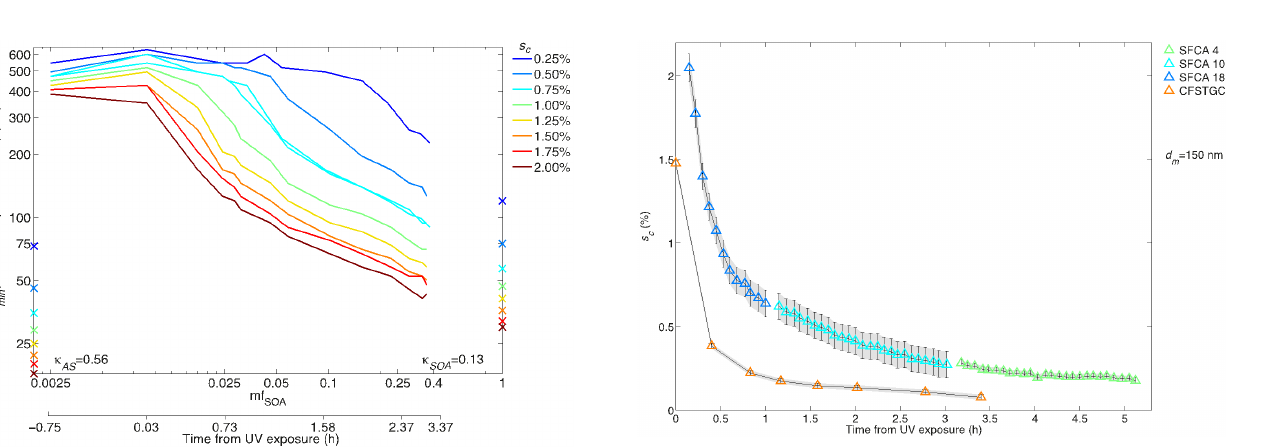
Figure 4. The minimum mobility diameter ( d m , min ) required for activation of the diesel exhaust particles (DEP3) at different super- saturations (supersaturation; colour coded) with respect to the SOA mass fraction (mf SOA (AMS)), for the whole aerosol measured by SP-AMS. As the mf SOA (AMS) increases, the activation properties of the diesel exhaust aerosol particles improve, i.e. there is an in- crease of activated particles of smaller sizes for a certain supersatu- ration. Also shown are the theoretical values for ammonium sulfate particles (AS, κ AS ≈ 0.56, organic fraction = 0) and organic parti- cles ( κ SOA ≈ 0.13, organic fraction = 1). Note that before and just after the UV exposure only about <1% of the particles are acti- vated.